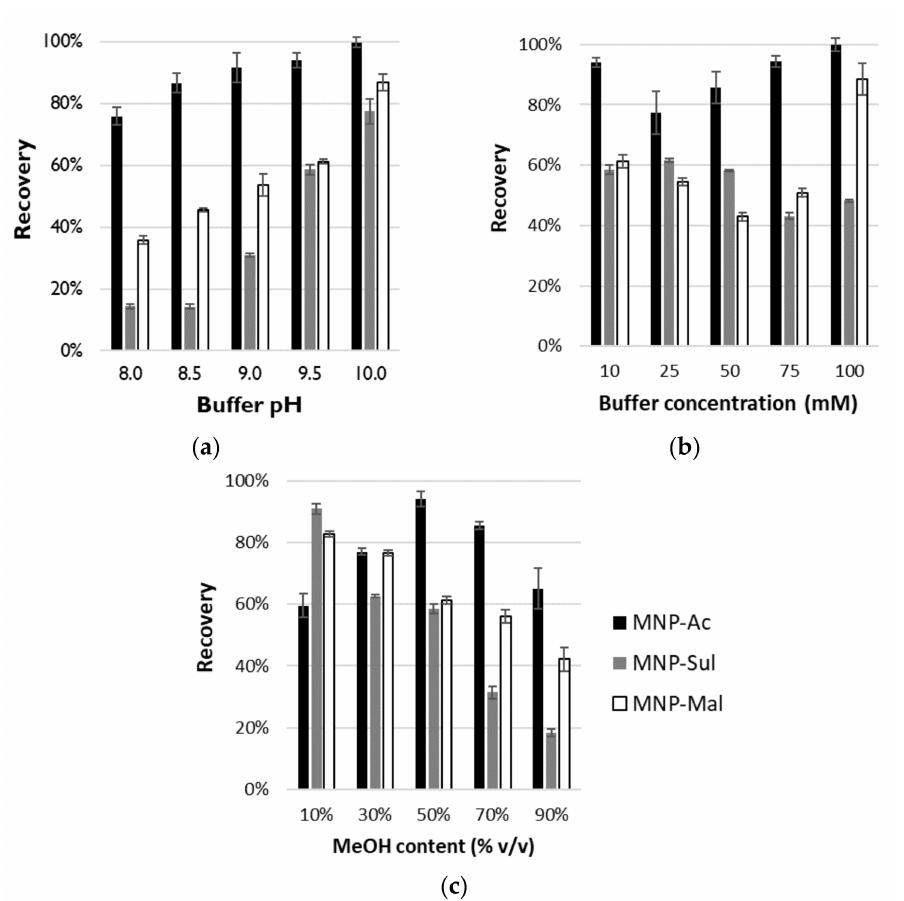
Figure 4. The influence of the elution solvent pH ( a ), and salt concentration ( b ), and methanol content ( c ) in the elution solvent on the extraction recovery for MNP-Ac (black bars), MNP-Sul (gray bars), and MNP-Mal (white bars). Experimental conditions in the